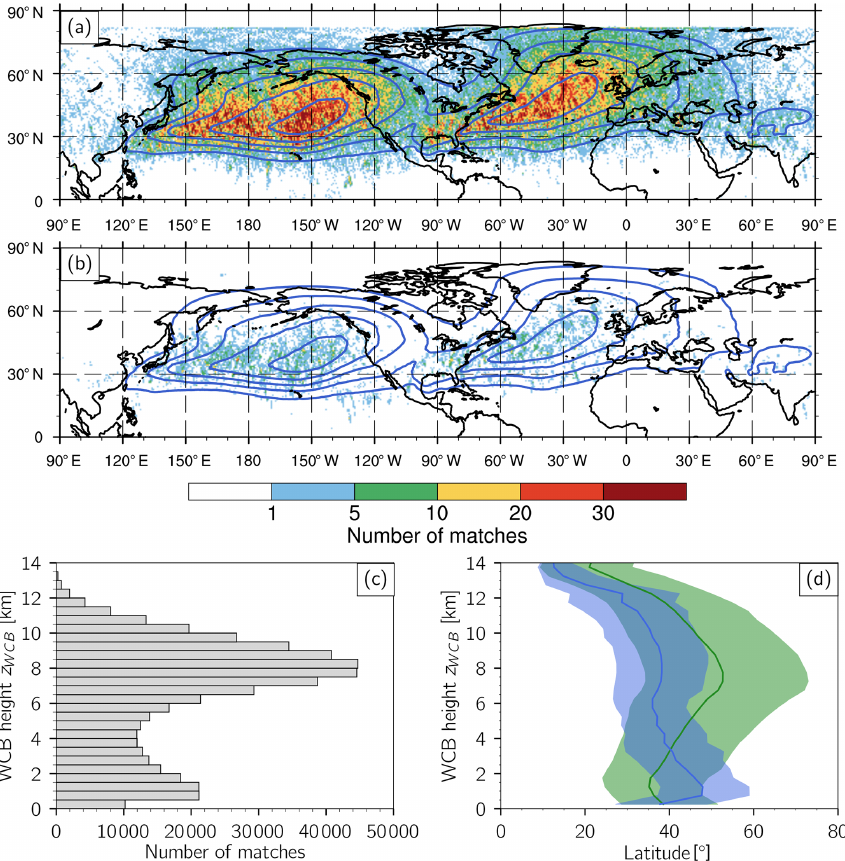
Figure 4. (a) Spatial distribution of the WCB trajectories matching with the satellite track (shading). The colours indicate the number of matches at each grid point. Overlaid is the ERA5-based climatological frequency of WCB trajectories for December–February 1980–2018 (blue contours every 10%), whereby all time steps between the start ( t = 0h) and the end ( t = 48h) of the trajectories are considered. (b) As in (a) but for strong WCBs, i.e. the top 5% of the matches with highest reflectivity values in each vertical height bin. (c) Height distribution of the matches. (d) Latitude of the matches as a function of their height for all WCBs (green) and strong WCBs (blue). The green and blue lines show the mean over the matches, and the shadings represent the range between the 10th and the 90th